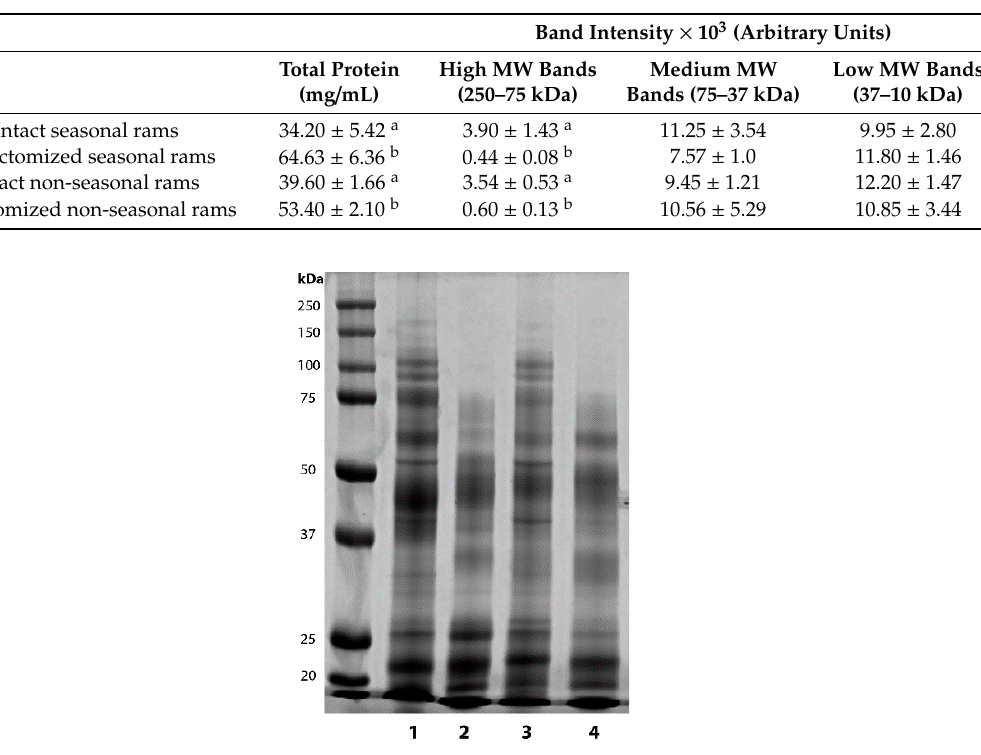
Figure 1. Representative image of SDS-PAGE of seminal plasma proteins from intact and vasectomized rams subjected to temperate (seasonal rams) or equatorial (non-seasonal rams) photoperiod. 1: intact seasonal, 2: vasectomized seasonal, 3: intact non-seasonal, 4: vasectomized non- seasonal.